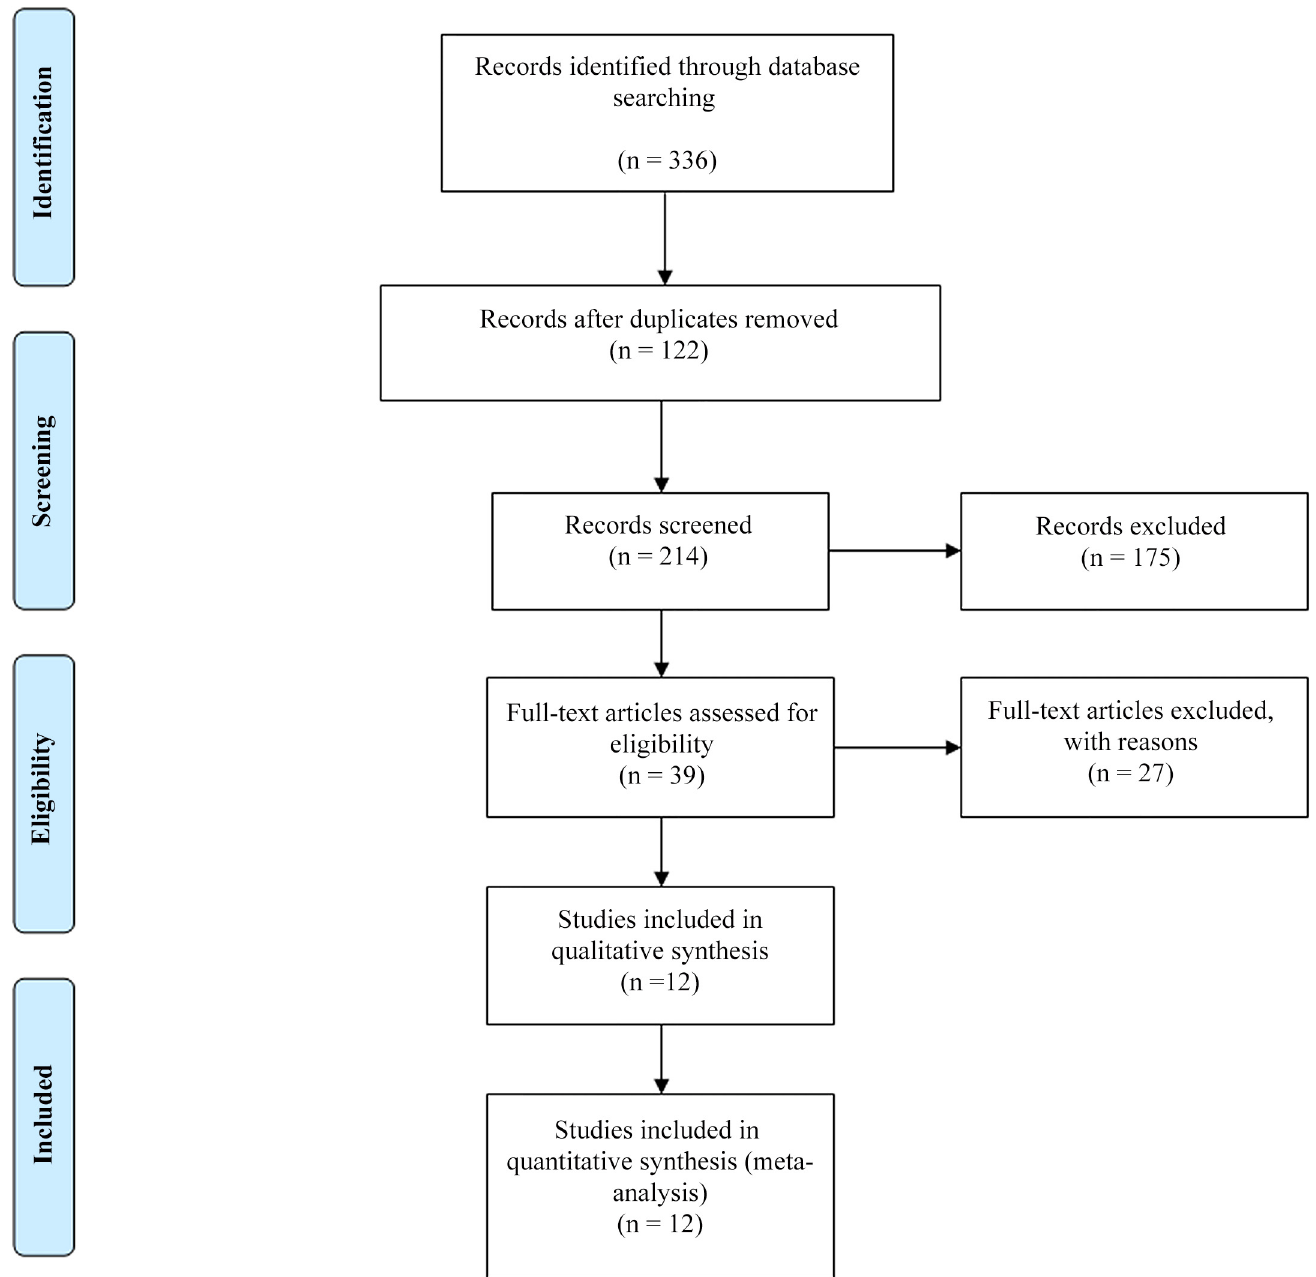
Fig 1. Literature search results for publications related to caffeine consumption during pregnancy and risk of low birth weight.